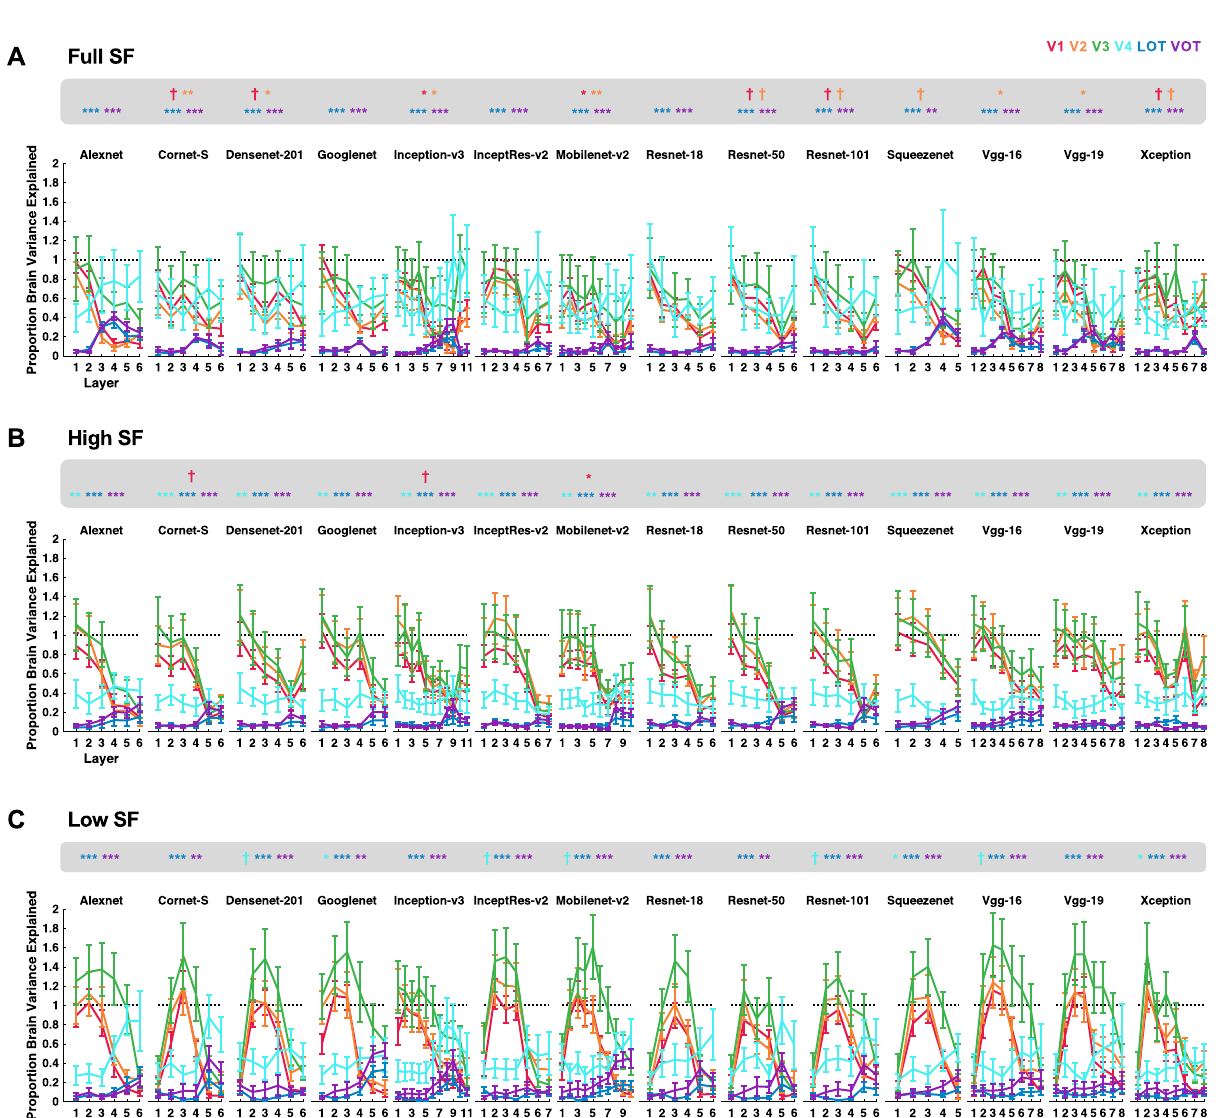
Fig. 4 Quantifying the proportion of explainable brain RDM variance captured by each sampled CNN layer in Experiment 2 for the processing of images from real-world object categories. A Results for Full SF images. B Results for High SF images. C Results for Low SF images. N = 10 human participants. The asterisks at the top of each plot mark the signi fi cance level of the difference between 1 and the highest proportion of variance explained by a CNN for each brain region; one-tailed t tests were used and all p values reported were corrected for multiple comparisons for the six brain regions included using the Benjamini – Hochberg procedure. Error bars indicate standard errors of the means. † p < 0.1, * p < 0.05, ** p < 0.01, *** p < 0.001. Source data are provided as a Source Data fi